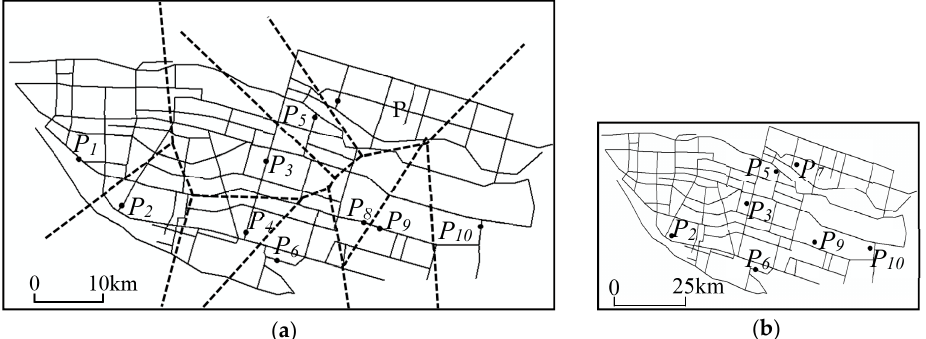
Figure 14. Experiment 1 for testing the algorithm based on the ordinary Voronoi diagrams and comparing it with the new algorithm: ( a ) ordinary Voronoi diagram of the points and ( b ) generalized point data at scale 1:25K. The maps are not shown exactly to scale.